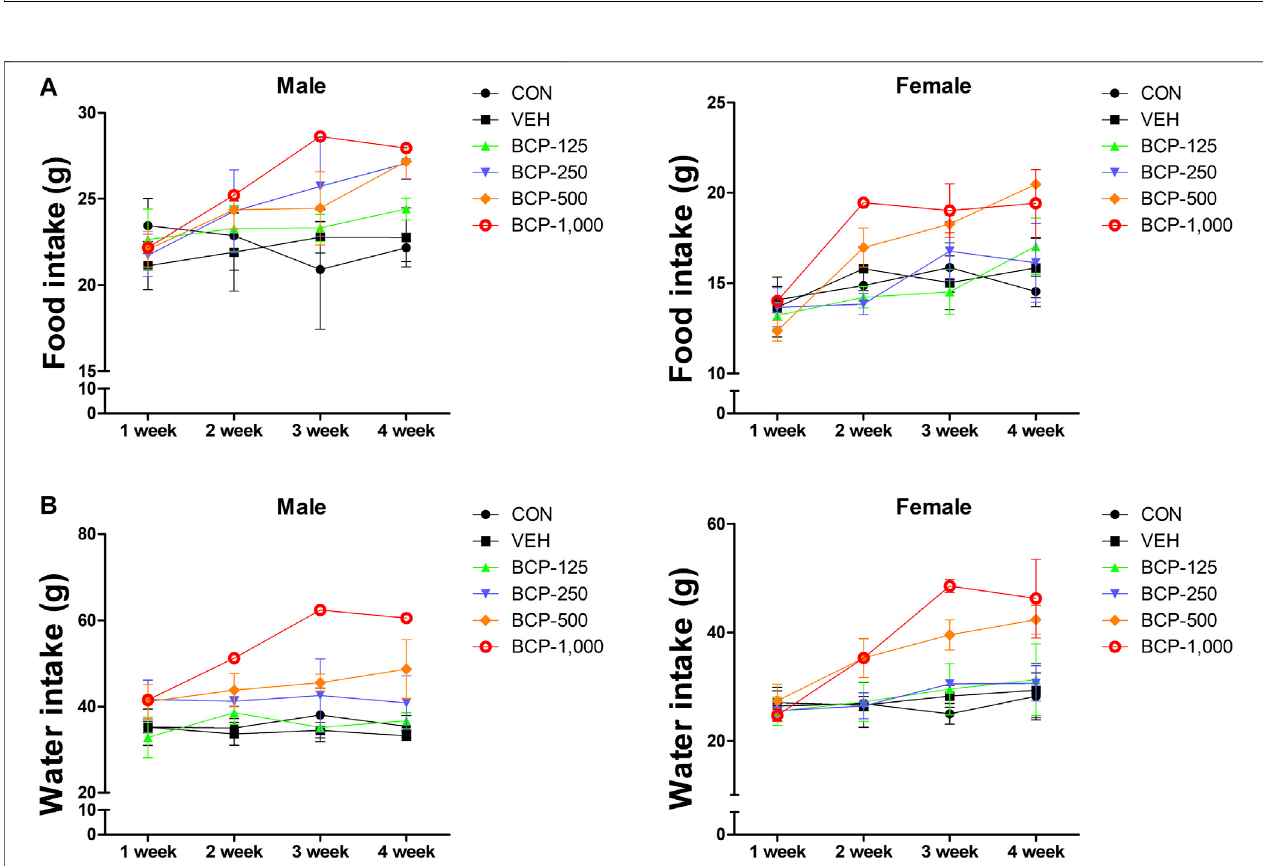
FIGURE2| Effect ofBCPontheweeklyfoodand waterconsumptionafteroraladministration inmaleandfemaleratsfor28 days.A,weeklyfoodconsumption.B, weekly water consumption. Data are expressed as the mean ± SD.